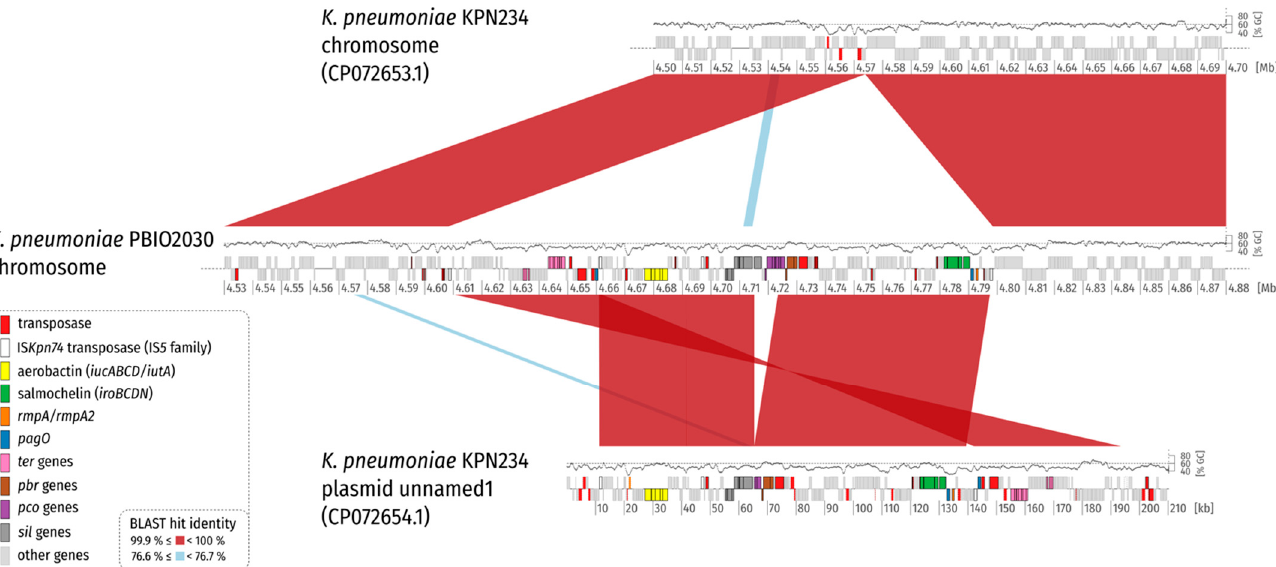
Figure 3. Synteny plot of K. pneumoniae PBIO2030 and KPN234 chromosome, and plasmid unnamed1. For clarity, only BLAST hits with a length of at least 1% of the length of the shorter replicon in the comparison are shown (2000 bp and 2102 bp for comparison 1 and 2, respectively). Coding sequences (CDS) are colored according to the legend. A GC plot created by a sliding window (1000 bp, step size = 1 bp) approach is drawn above the replicon backbones. Please note that the GC content is lower for the virulence plasmid and the inserted plasmid region on average. This is also evident in Figure 2. The plot illustrates that a part of the virulence plasmid is missing in its integrated